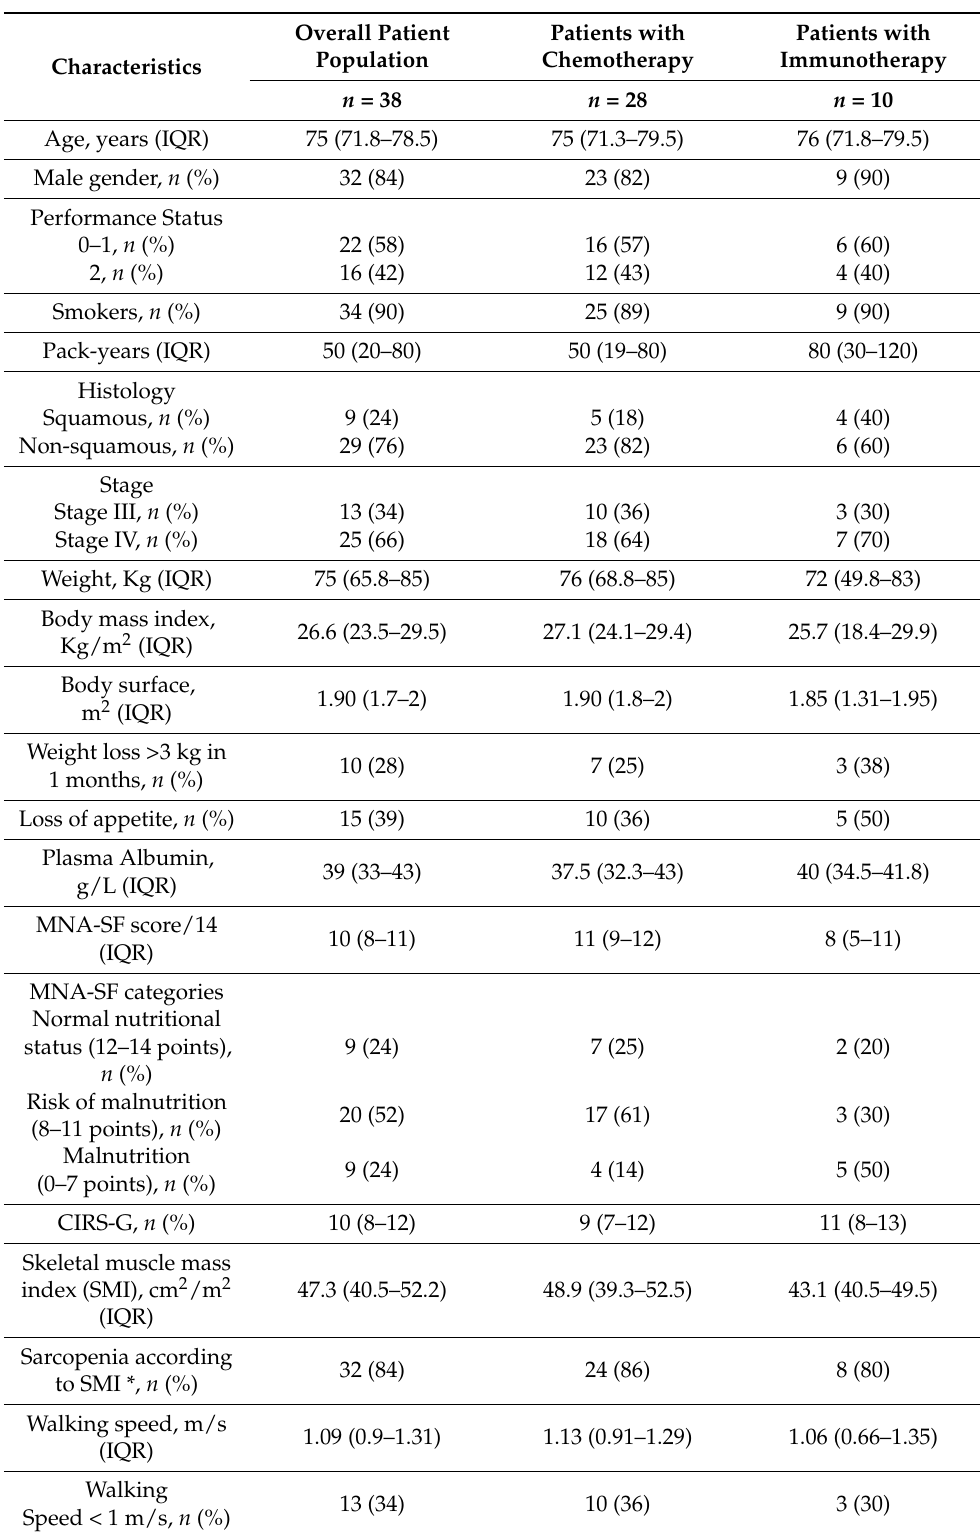
Table 1. Patient characteristics at